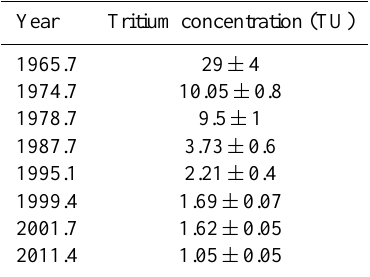
Table A2. Surface water tritium values 1965–2011. Years as in Ta- ble A1, errors are standard